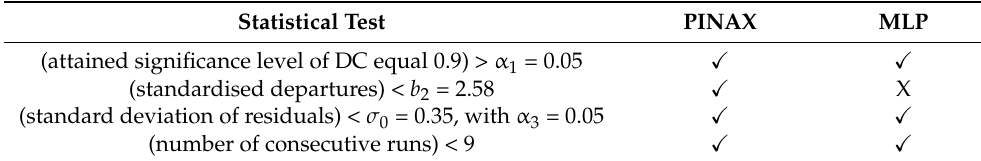
Table 1. The statistical tests of PINAX. Statistical